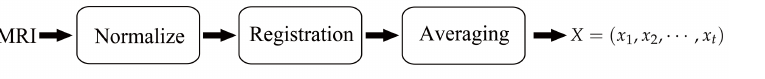
Figure 2. Data preprocessing procedures. We use FEAT to normalize the fMRI data (4D data), and then use FLIRT to register the data. Finally, we average voxel values for each 94 brain